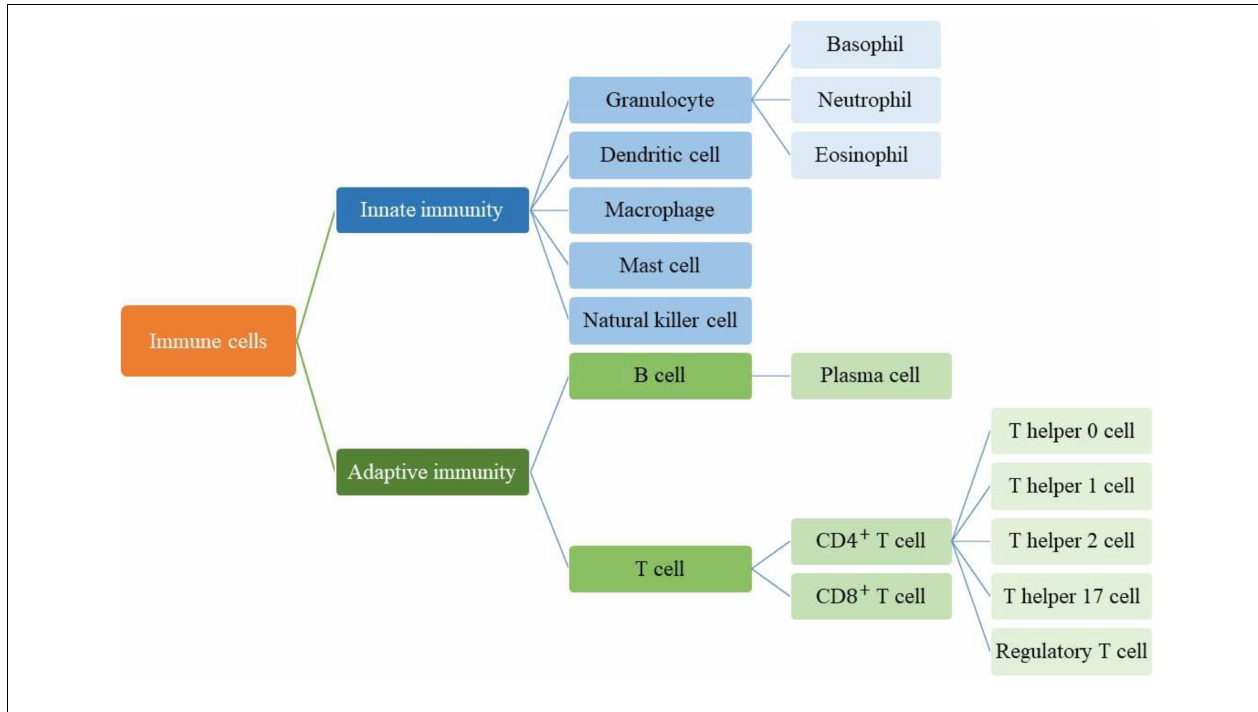
FIGURE 1 | Immune system cells in innate and adaptive immunity responses.